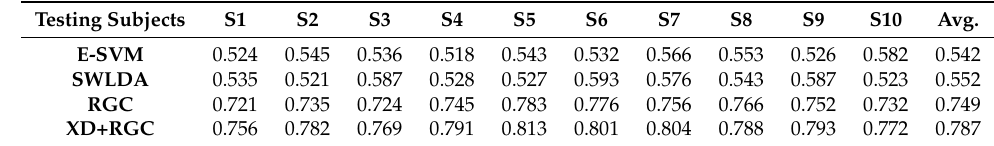
Table 4. One-to-One transfer learning AUC score results of Dataset II.